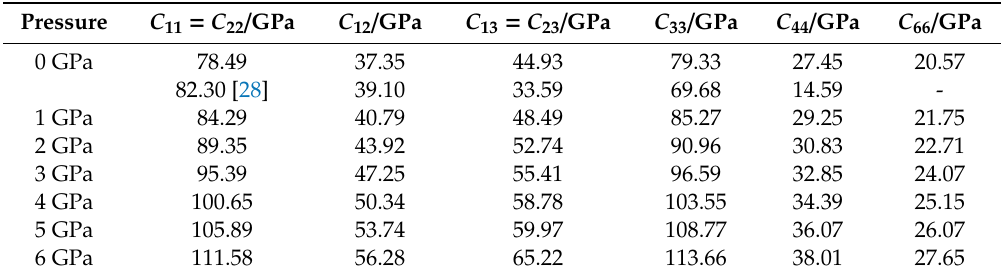
Table 3. Elastic constants of Mg 23 Al 30 under di ff erent pressures.